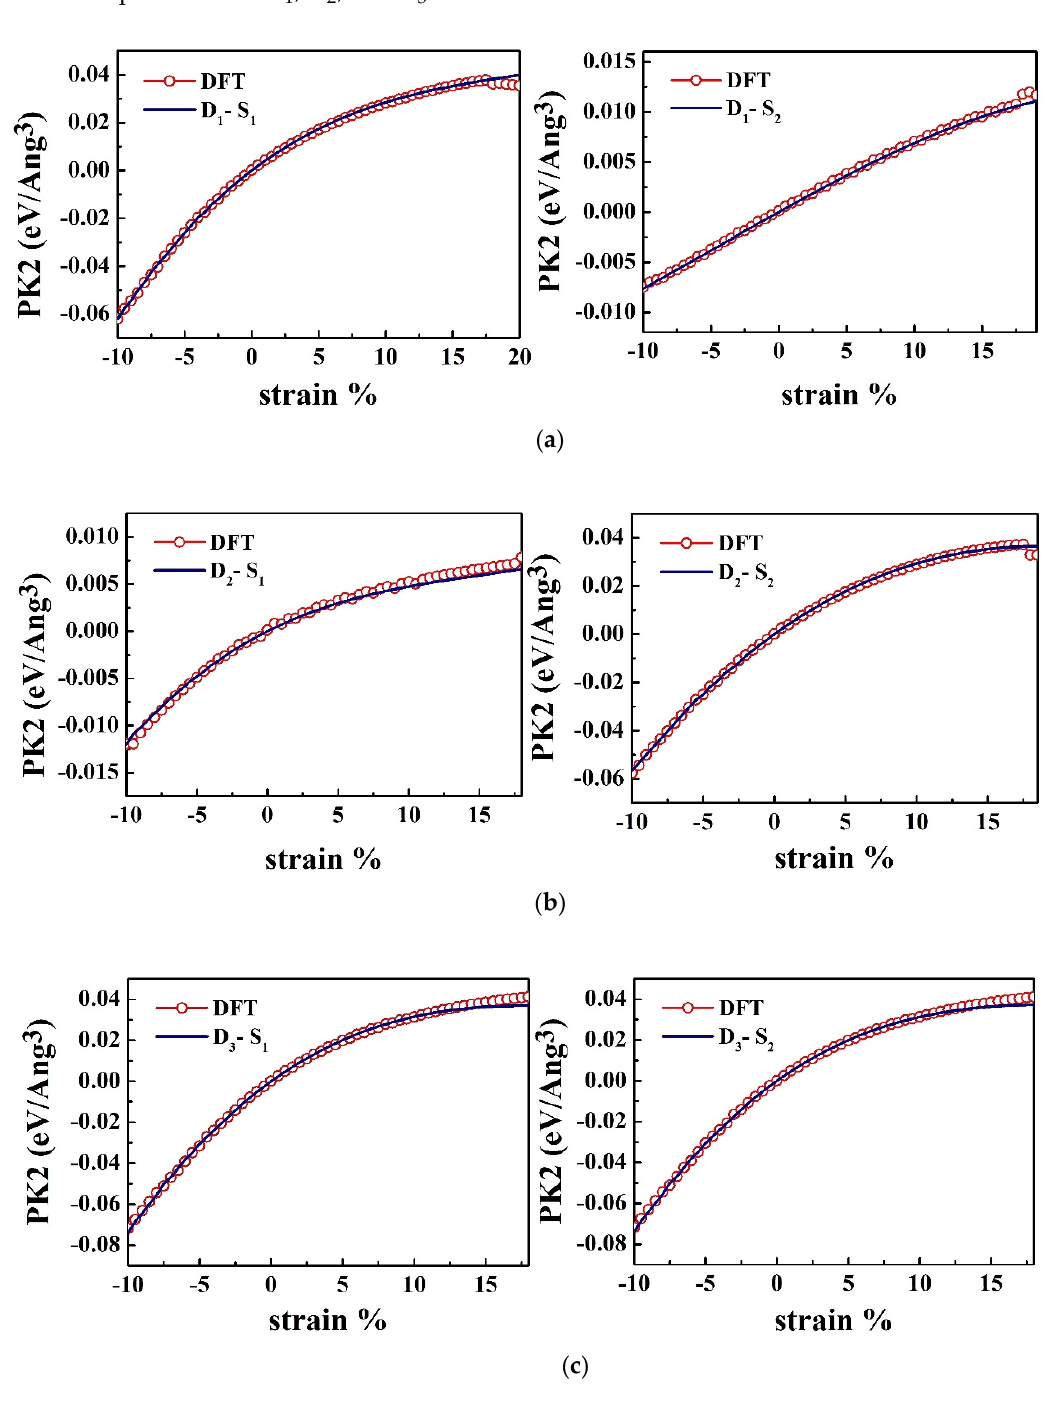
Figure 3. Strain-stress relationships for three types of strain, namely ( a ) D 1 ( b ) D 2 ( c ) D 3 , fitted with S 1 and S 2 , which denote to the x and y components of the stress, respectively.